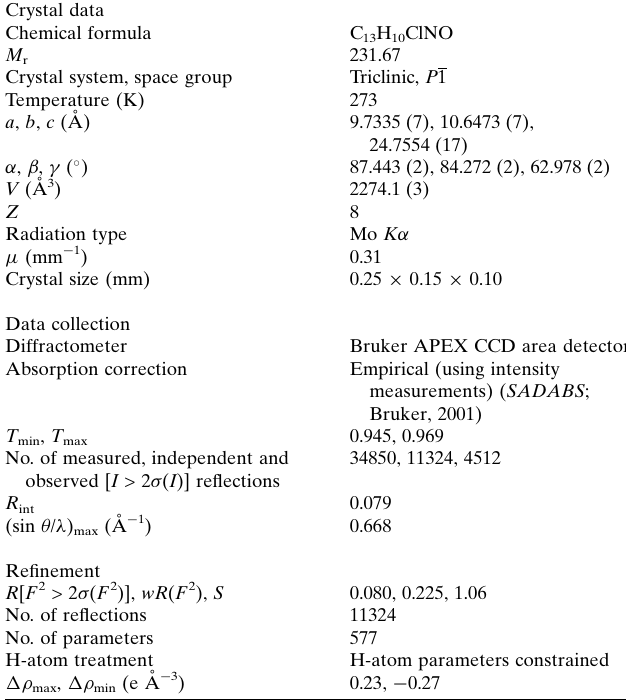
Table 2 Experimental details.